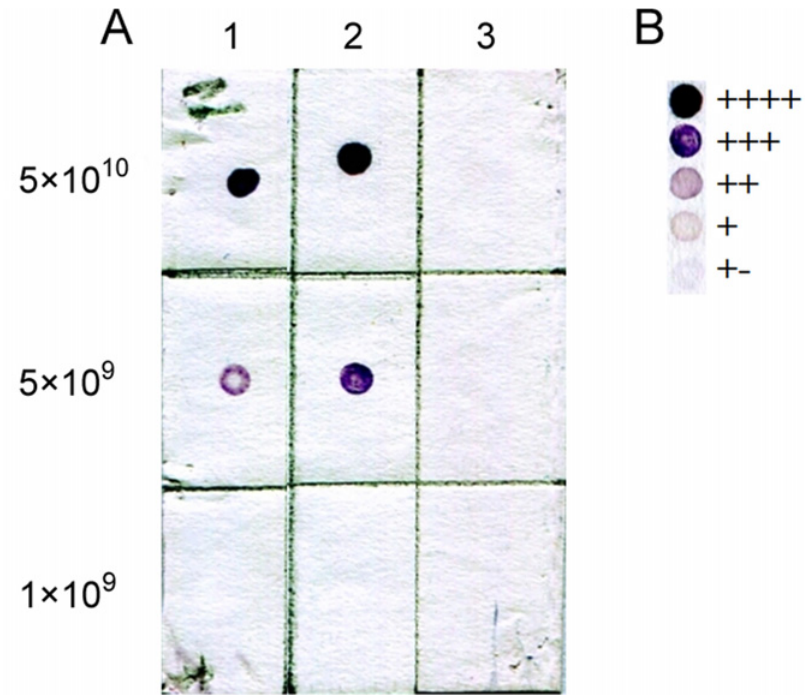
Fig 1. Specific recognition of phage clones selected during biopanning by mAb VRC01. (A) Lane 1, phage clone carrying C4 peptide; lane 2, phage clone carrying C1 peptide; Lane 3, phage clone with no random peptide insert (negative control). Phage titer (in plaque forming units per ml) is labeled to left the dot blot. (B) Spot intensity related to the symbols.